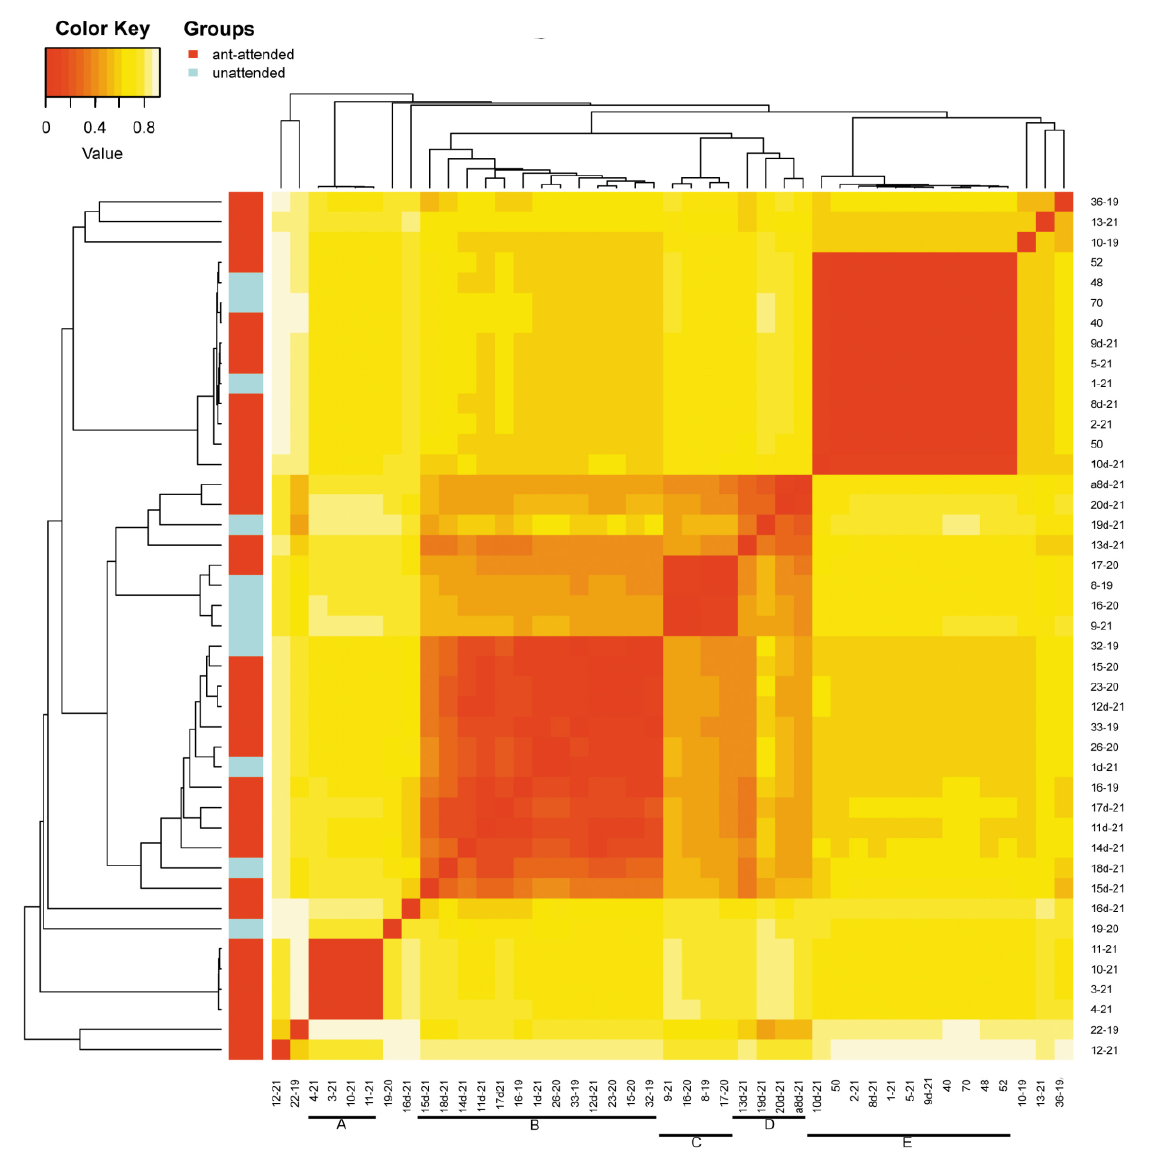
Figure 6. Heatmap of OTU beta diversity clustered with the weighted Unifrac method in reference to ant attendance of the studied samples (sample numbers as in Supplementary Table S1; bars with letters mark clades).